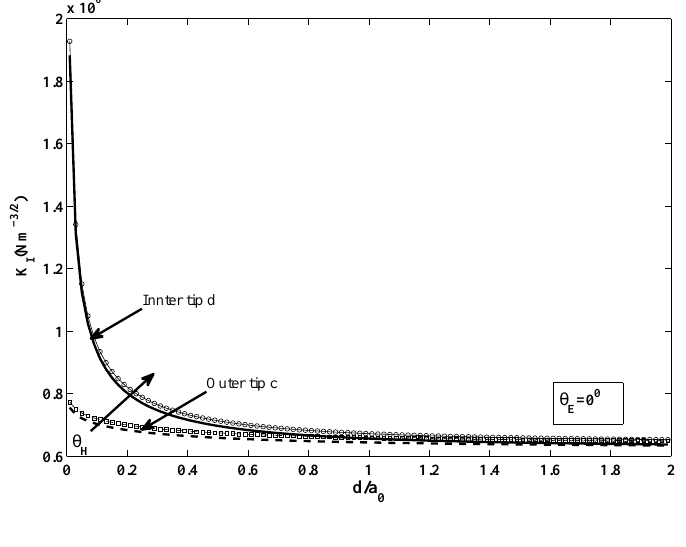
Fig. 11 SIF versus inter-crack distance for different magnetic poling with fixed electric